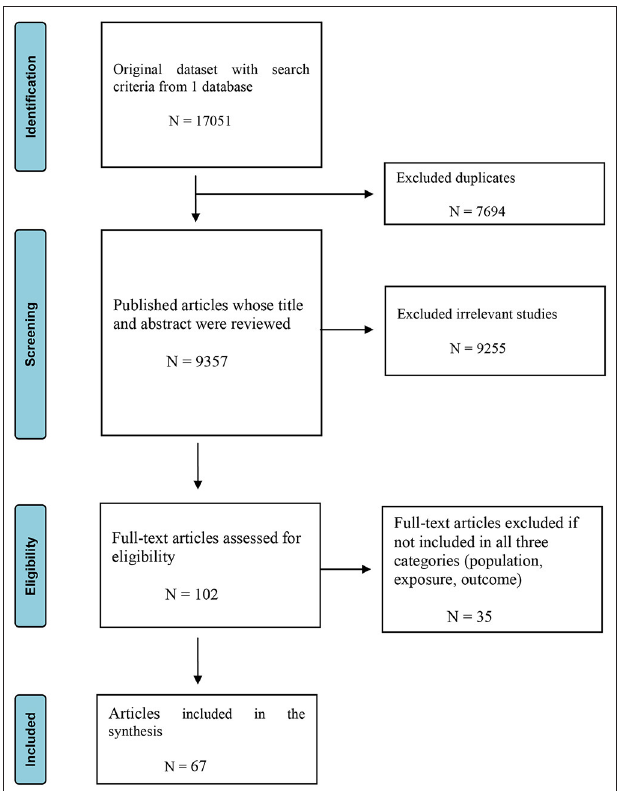
FIGURE 2 | PRISMA diagram illustrating the steps of the systematic literature review.